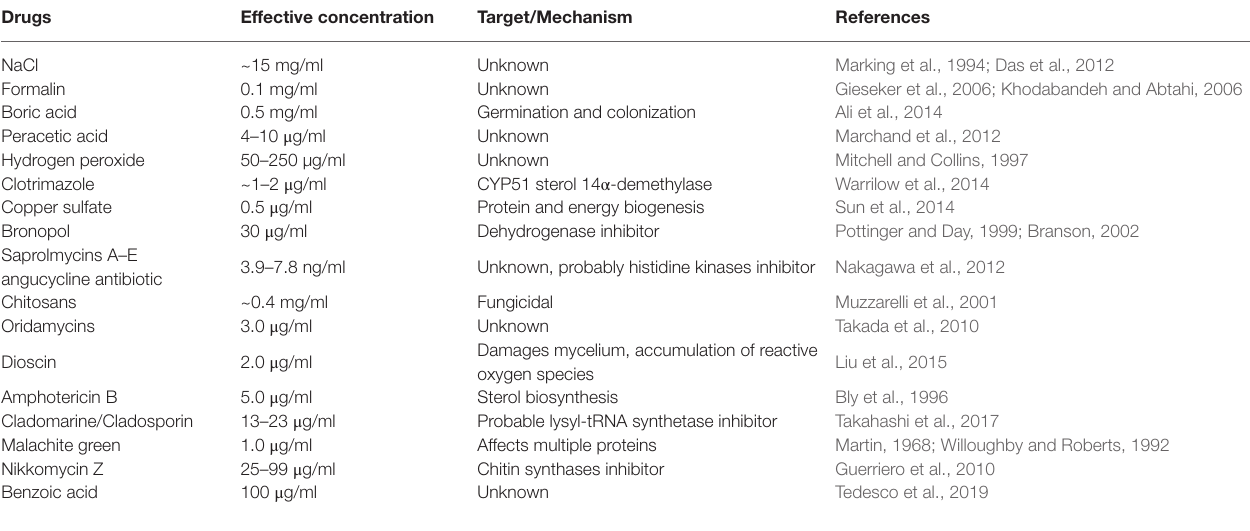
TABLE 1 | List of compounds reported earlier to be effective in controlling the growth and spread of S. parasitica in aquaculture.